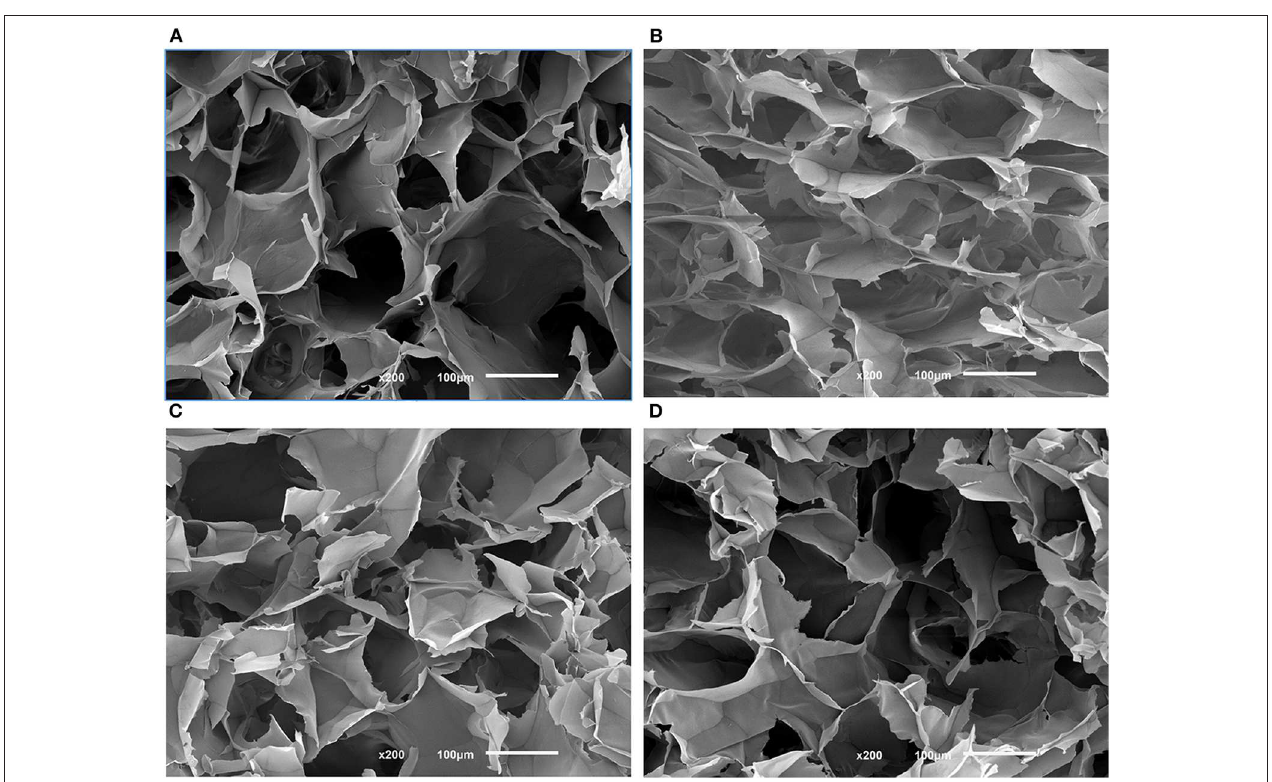
FIGURE 3 | Morphological features of different SEM images of the cross-sections of the APC80B (A) , APC80C (B) , APC20B (C) , and APC20C (D) scaffolds. Scale bars represent 100 µ